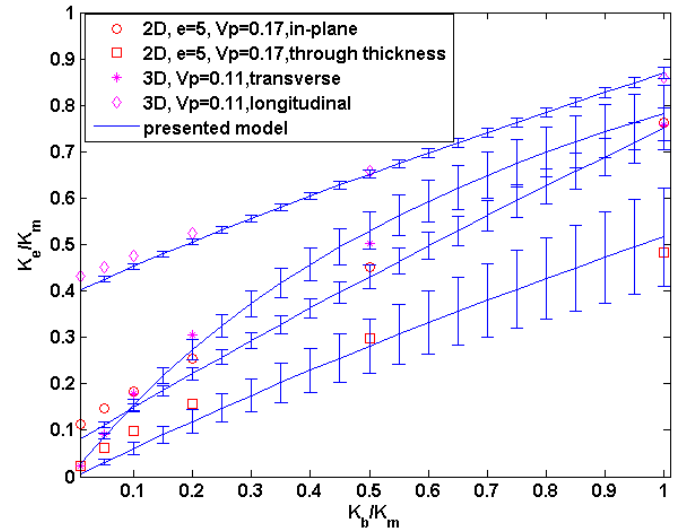
Figure 10. The reduced thermal conductivity of the three-phase bundle structures with K p / K s = 0.01. The bundles and the matrix are considered as isotropic and the bundles thickness is 140 μ m. The error bars reflect the range of K e due to the uncertainty of β values.